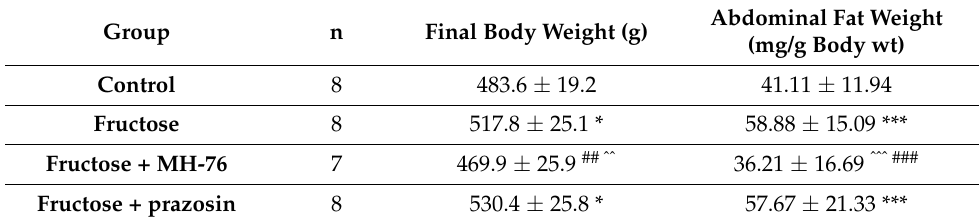
Table 2. Physiological parameters of Control, Fructose-, Fructose + MH-76- and Fructose + prazosin- treated rats at the end of the experimental period. The presented data were already published in [24]. Values are presented as mean ± ∆ /2, where ∆ is a width of the 95% CI.